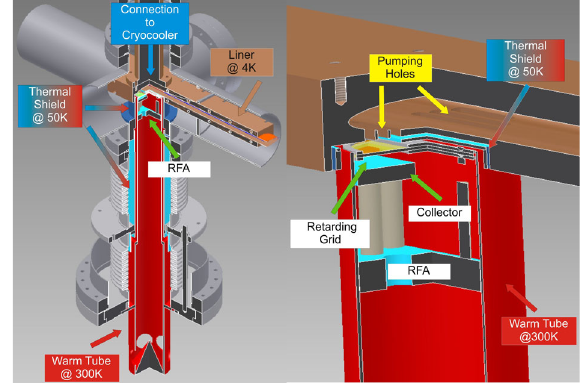
FIG. 3. Drawing of the diagnostics tube.